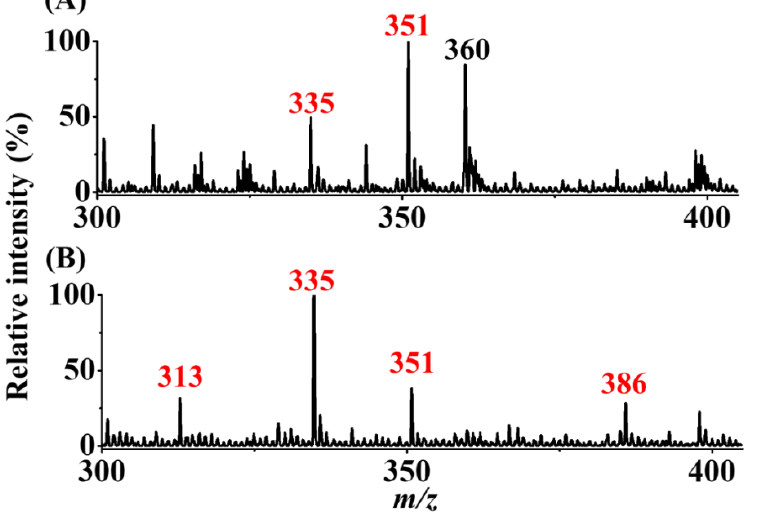
Figure 6. Examination of selectivity. SPME-CFI mass spectra of the samples (7.5 mL) containing AFB1 (100 nM) and AFG1 (300 nM) obtained ( A ) before and ( B ) after enrichment. The elution solvent (10 µ L) contained acetonitrile/ethanol/deionized water (2:2:1, v / v / v ) with the addition of butylamine (1 µ